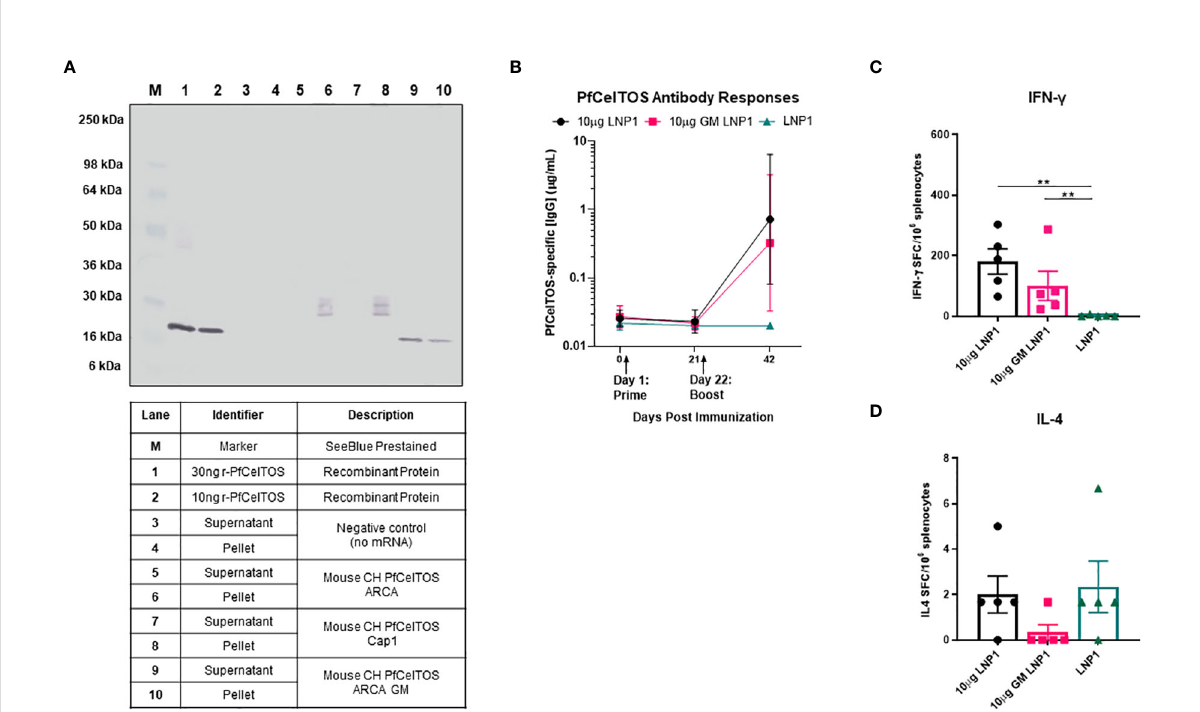
FIGURE 2 Effect of N-glycosylation on in vitro and in vivo responses. (A) Western blot analysis of CHO cells transfected with mRNAs pfceltos ARCA, pfceltos Cap1 and pfceltos ARCA GM. pfceltos mRNA transcripts were codon harmonized (CH) for optimal expression in mice and encoded with the native falciparum celtos signal sequence (Wt-SS). Cell culture supernatants and cell lysates were harvested at 24 hours post-transfection to assess for the effect of N-glycosylation on protein translation. (B) BALB/cJ mice were immunized intramuscularly (IM) two times at a three-week interval with 10µg of pfceltos mRNA encapsulated into LNP1 (10µg LNP1), 10µg pfceltos mRNA with glycosylation site modi fi ed (GM) in LNP1 (10µg GM LNP1) or LNP1 alone ( n= 5 per group). PfCelTOS-speci fi c IgG antibody concentrations (µg/mL) were quanti fi ed in sera at